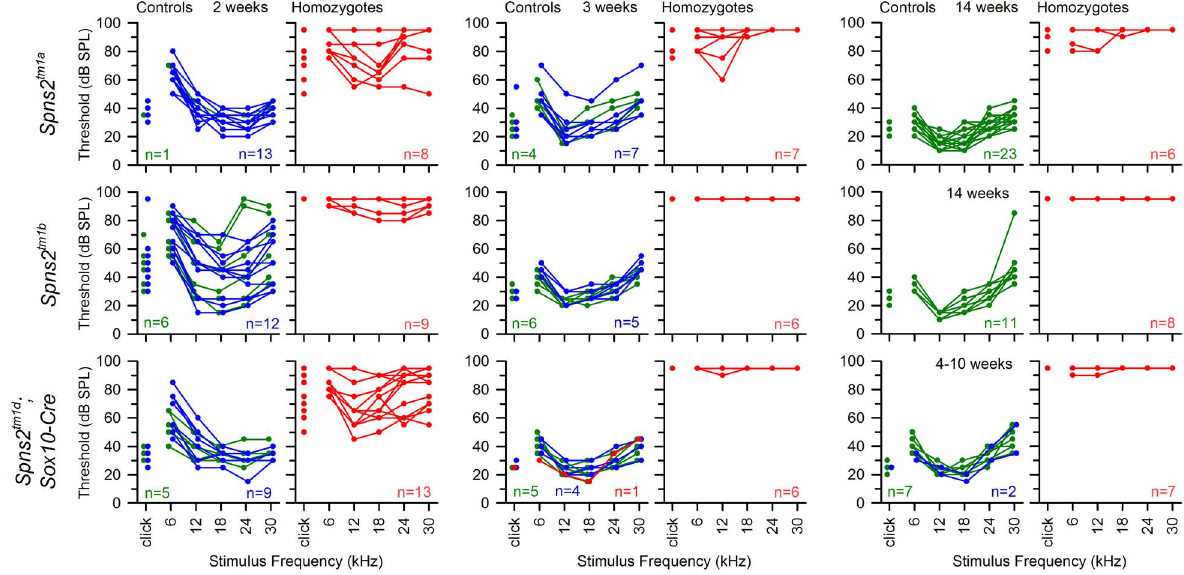
Figure 11. The hearing loss of Spns2 tm1a/tm1a , Spns2 tm1b/tm1b and Spns2 tm1d/tm1d ; Sox10-Cre mice showed a similar pattern of progression. ABR thresholds of individual homozygotes (red), heterozygotes (blue) and wildtypes (green) are shown at 2, 3 and 14 or 4–10 weeks old. The control mice had immature thresholds at 2 weeks old and continued to mature to normal hearing levels at 3 weeks old. Spns2 tm1a/tm1a and Spns2 tm1d/tm1d ; Sox10-Cre mice displayed progressive hearing loss from 2 to 3 weeks old. The red line in the middle bottom panel represents a control mouse homozygous for Spns2 tm1c but without carrying Sox10-Cre , and thus had no conditional knockout of Spns2 in the inner ear and normal